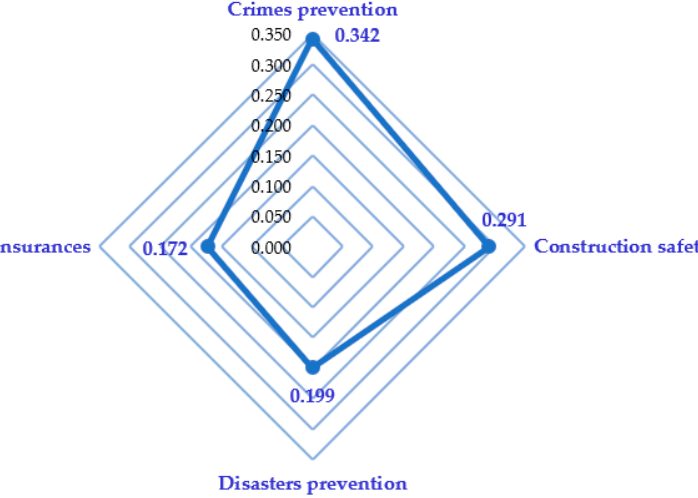
Figure 10. Relative weights of the assessment indicators for “Safety”.